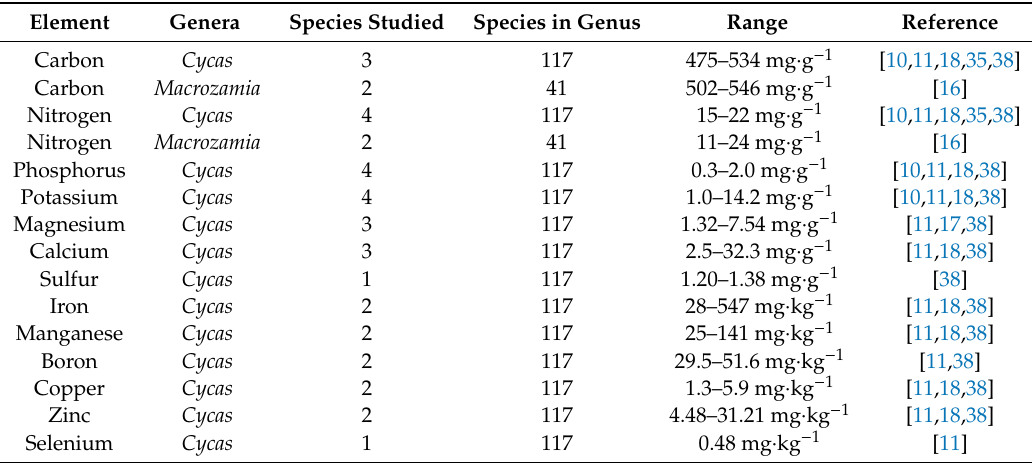
Table 3. Published ranges in leaf litter concentrations of macronutrients, micronutrients, and beneficial elements for cycad